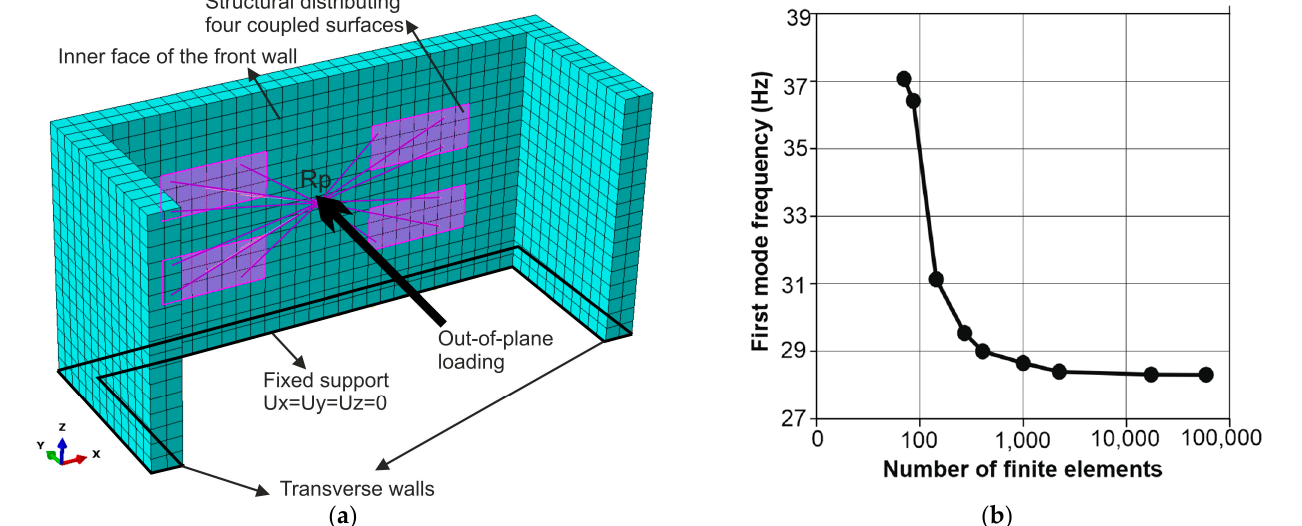
Figure 9. ( a ) FE mesh and the coupled surfaces (purple areas) for four-point loading in the models, ( b ) mesh convergence plot based on the natural frequency of the first mode. ( b ) mesh convergence plot based on the natural frequency of the first